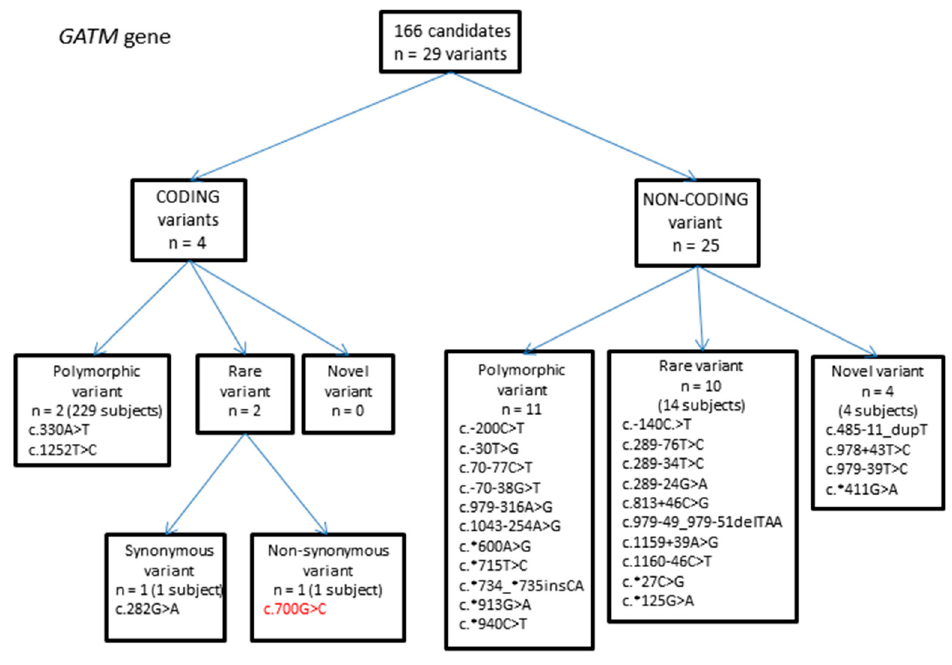
Figure 1. Flowchart summarizing variants identified in the glycine amidinotransferase ( GATM ) gene.